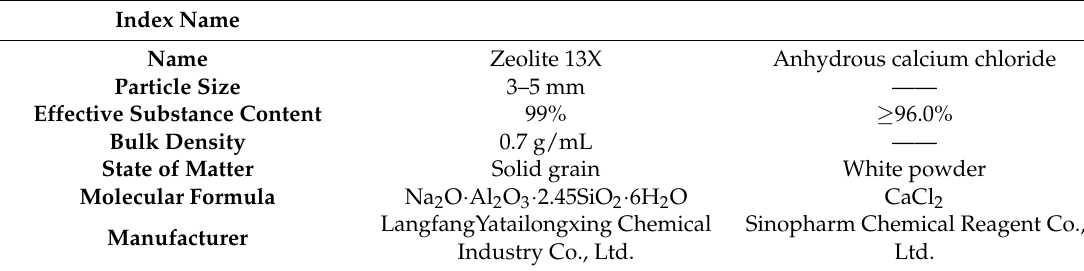
Table 1. Information of raw materials.